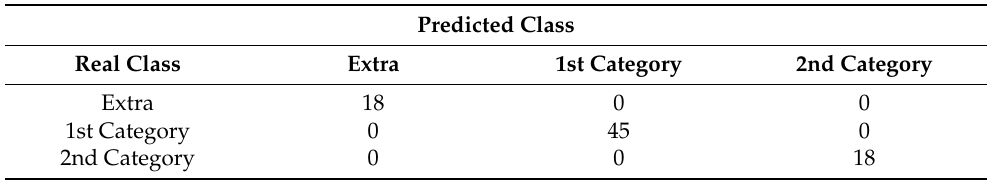
Figure 4. Score plot of the principal component analysis (PCA) analysis for table olives classified in different categories. Table 3. Confusion matrix obtained through PLS-DA for discrimination between control (healthy olives) and isolated defects. Values are expressed in number of